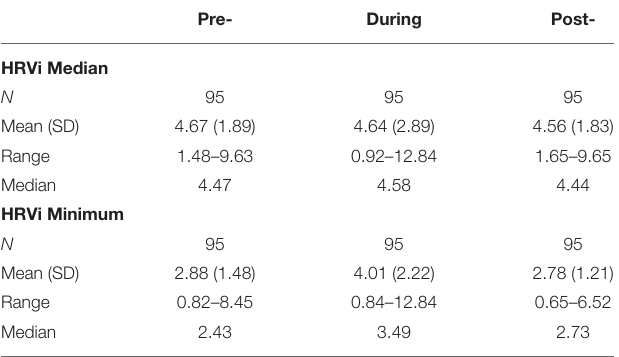
TABLE 3 | HRVi median and minimum pre-, during and post-VR.